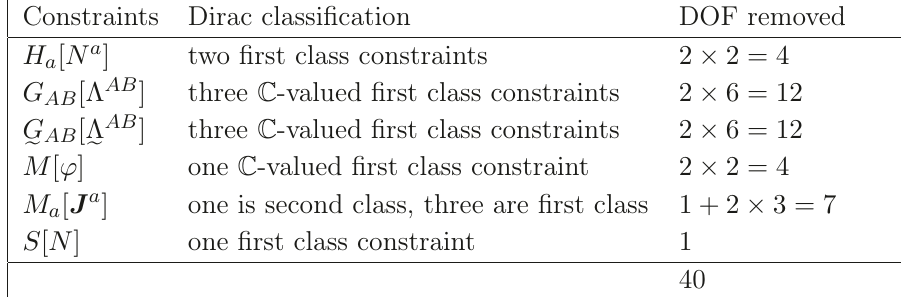
Table 1. The constraints remove forty dimensions from the phase space of the theory. The phase space has canonical coordinates A A Ba , π A , ℓ A and A 2 2 + 2 2) = 40 real dimensions. Therefore, all directions in phase space are just pure gauge × × directions. This renders the boundary theory topological. There are no local degrees of